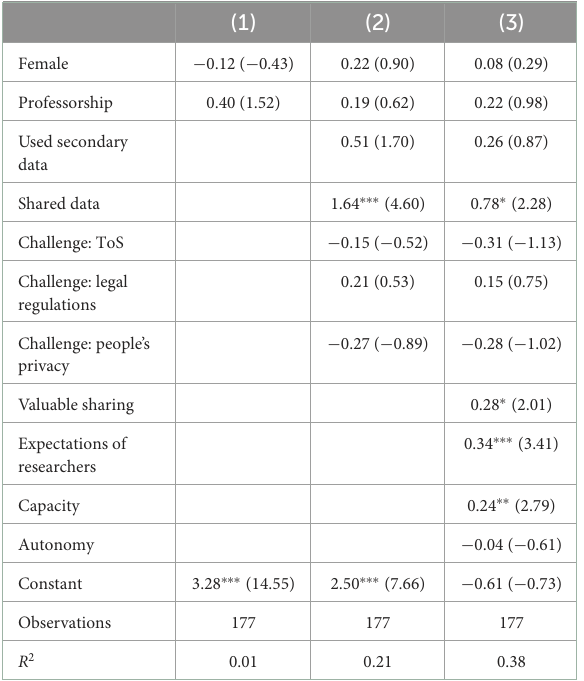
TABLE 2 Regression model to predict the intention to share data under controlled